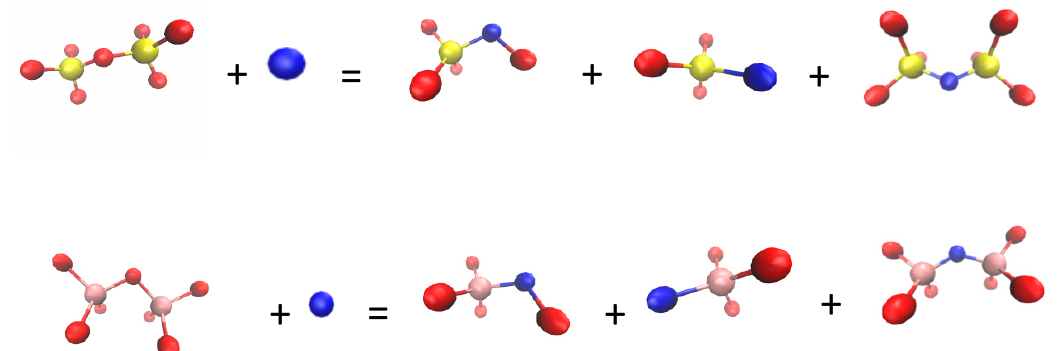
Figure 11. ( a ) Number of nonbridging fluorine and ( b ) bridging fluorine.